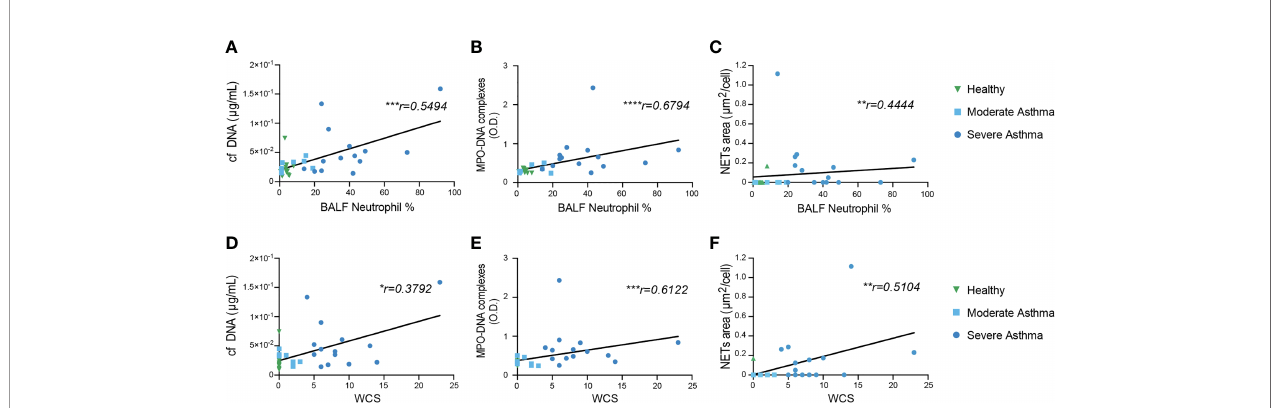
FIGURE 4 | BALF NETs correlate with BALF neutrophil percentage and disease severity score. (A – C) Correlation of (A) cf DNA, (B) MPO-DNA complexes and (C) NETs area/cell with BALF neutrophil percentage (%). (D – F) Correlation of (D) cf DNA, (E) MPO-DNA complexes and (F) NETs area/cell with disease severity (Weighted clinical score [WCS]). The correlation analysis used was non-parametric (Spearman ’ s correlation) performed on healthy control and asthmatic horses pooled into a single group. * , P <0.05; **, P <0.01; ***, P <0.001.